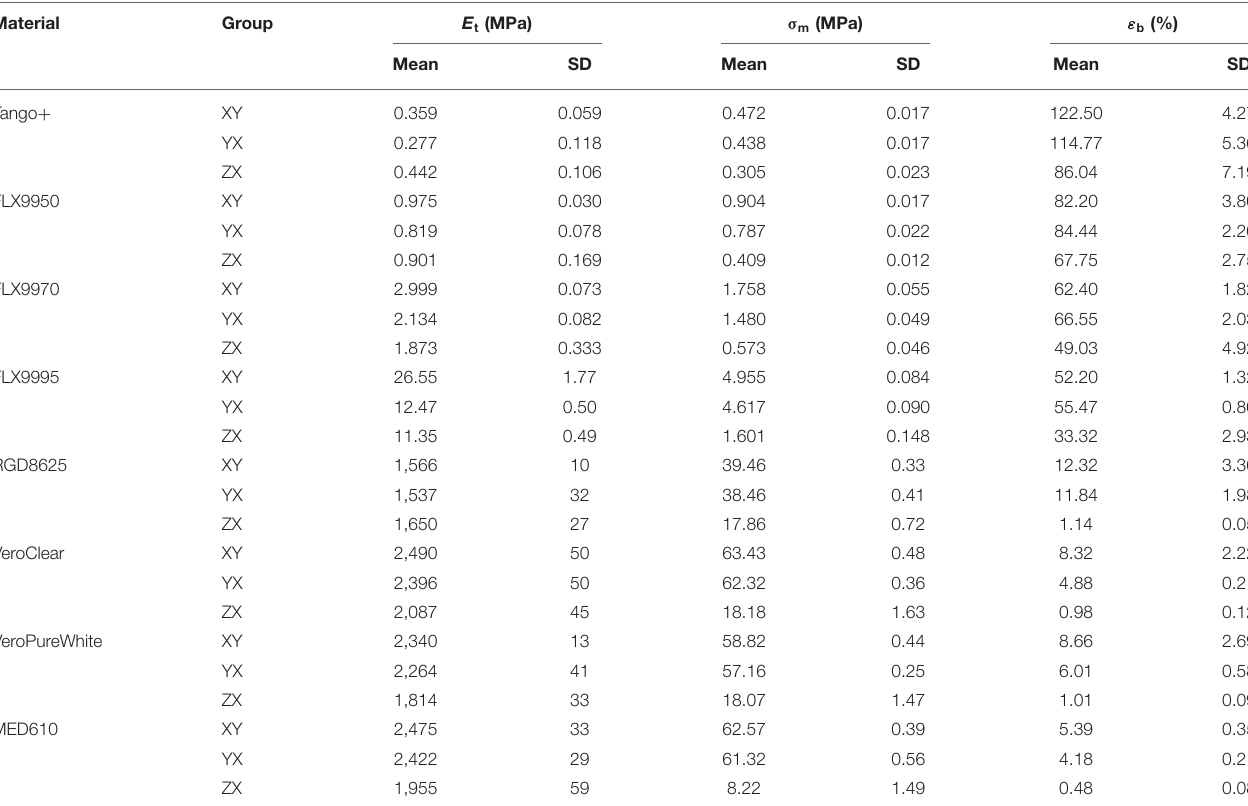
TABLE 2 | Mean mechanical data ( n = 6 for each mechanical property and each group) and corresponding standard deviations ( E t , tensile modulus; σ m , tensile strength; ε b , elongation at break).